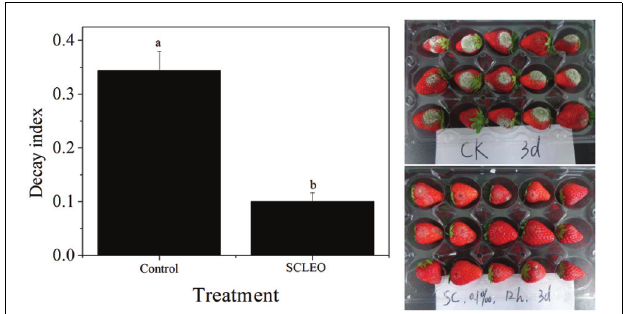
FIGURE 5 | Effects of SCLEO treatment versus the gray mold decay index in artificially inoculated strawberries. Vertical bars represent the standard error of the means. Bars labeled with the same letter are not significantly